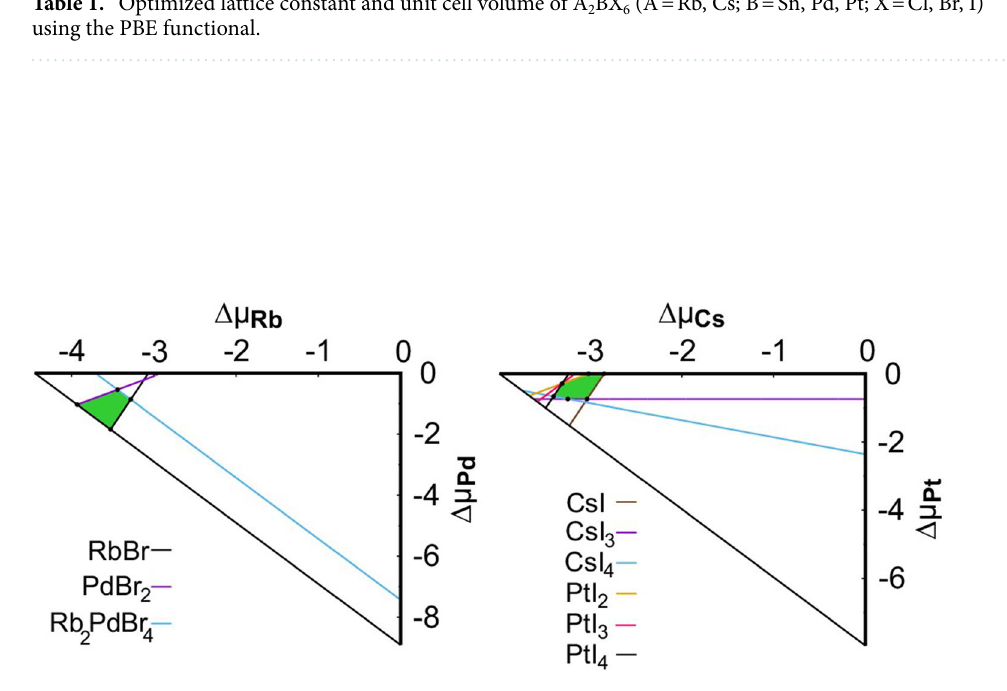
Figure 2. The stability diagrams of Rb 2 PdBr 6 (left) and Cs 2 PtI 6 (right). Each line in the diagrams indicates a known competing phase; in each case the stable region is indicated by the green